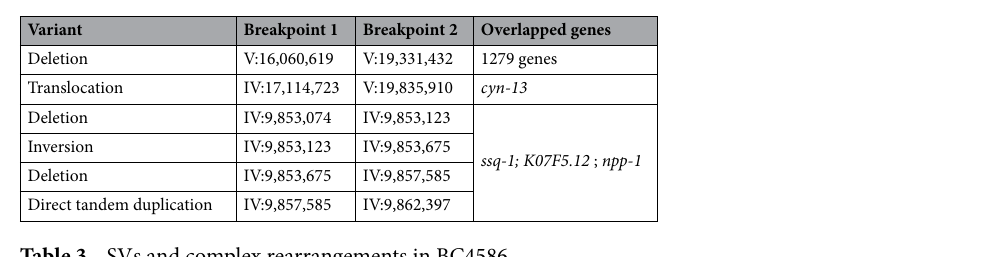
Table 3. SVs and complex rearrangements in